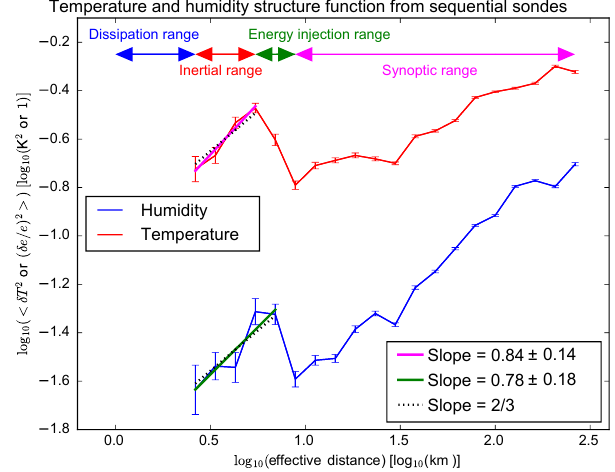
Figure 1. Temperature and water vapor structure